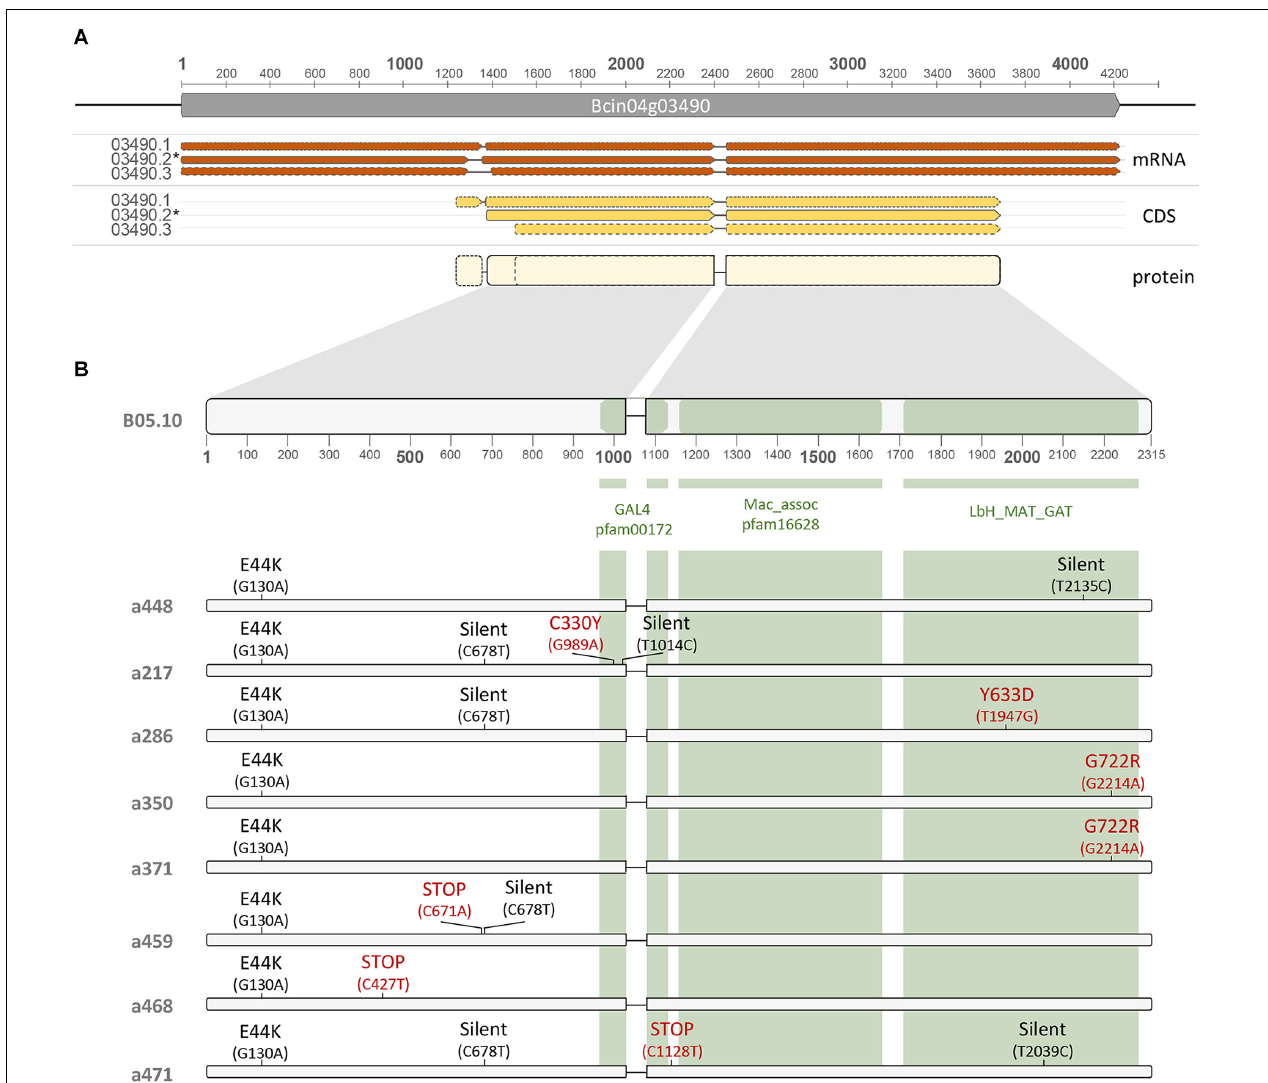
FIGURE 5 | (A) Organization of the Bcin04g03490 locus and polymorphisms in the alleles from the mycelial non-pathogenic field isolates. The three splice variants annotated in the locus, the corresponding coding sequences and the predicted sizes of the encoded isoforms are presented. Continuous lines frame the representations of the Bcin04g03490.2 splice variant, CDS and encoded protein, considered as the references (*) in this study. (B) Regions in the Bcin04g03490.2 CDS encoding the GAL4, Mac_assoc and LbH_MAT_GAT functional domains, represented by green boxes, identified in the encoded protein. Below the B05.10 allele scheme, the polymorphisms identified in the Bcin04g03490 alleles of the mycelial field isolates and of isolate B448 are presented. For each allele, the nucleotide polymorphisms are indicated in parenthesis relative to the ATG codon. Above each polymorphism, the effect on the encoded protein is indicated. GenBank accession numbers of Bcin04g03490 alleles are the following: a448 – MW682868; a371 – MW682869; a217 – MW682870; a286 – MW682871; a350 – MW682872; a459 – MW682873; a468 – MW682874; a471 – MW682875.